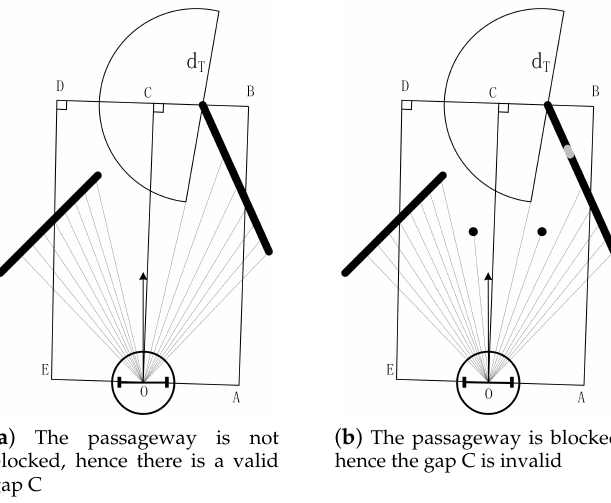
Figure 5. Examples of gaps. Rectangle CDEO and BCOA have a common side CD , and the lengths of sides CD and CB are equal to d T